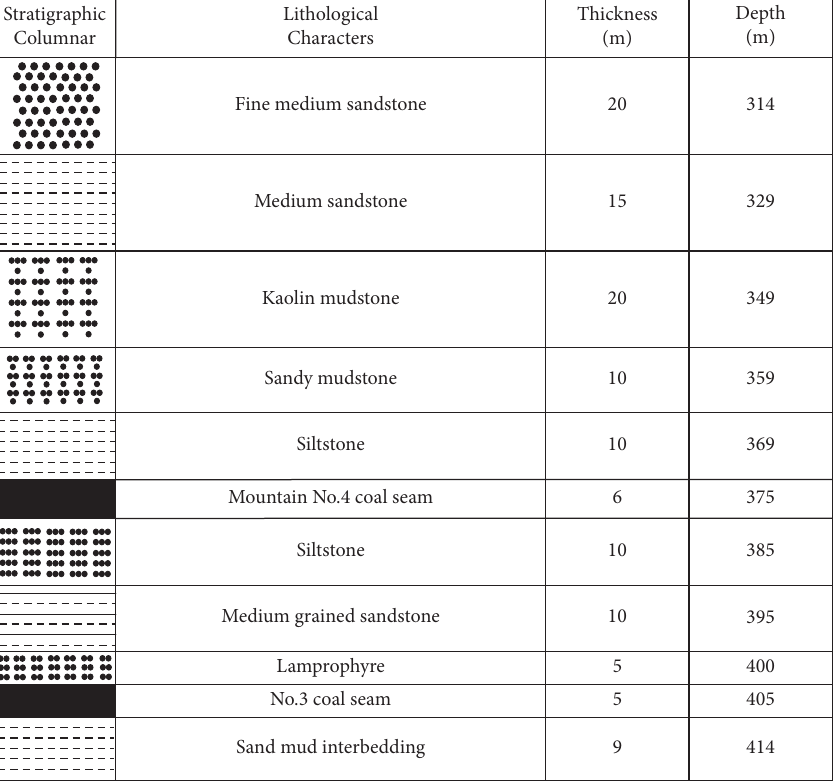
Figure 3: Comprehensive drilling histogram.